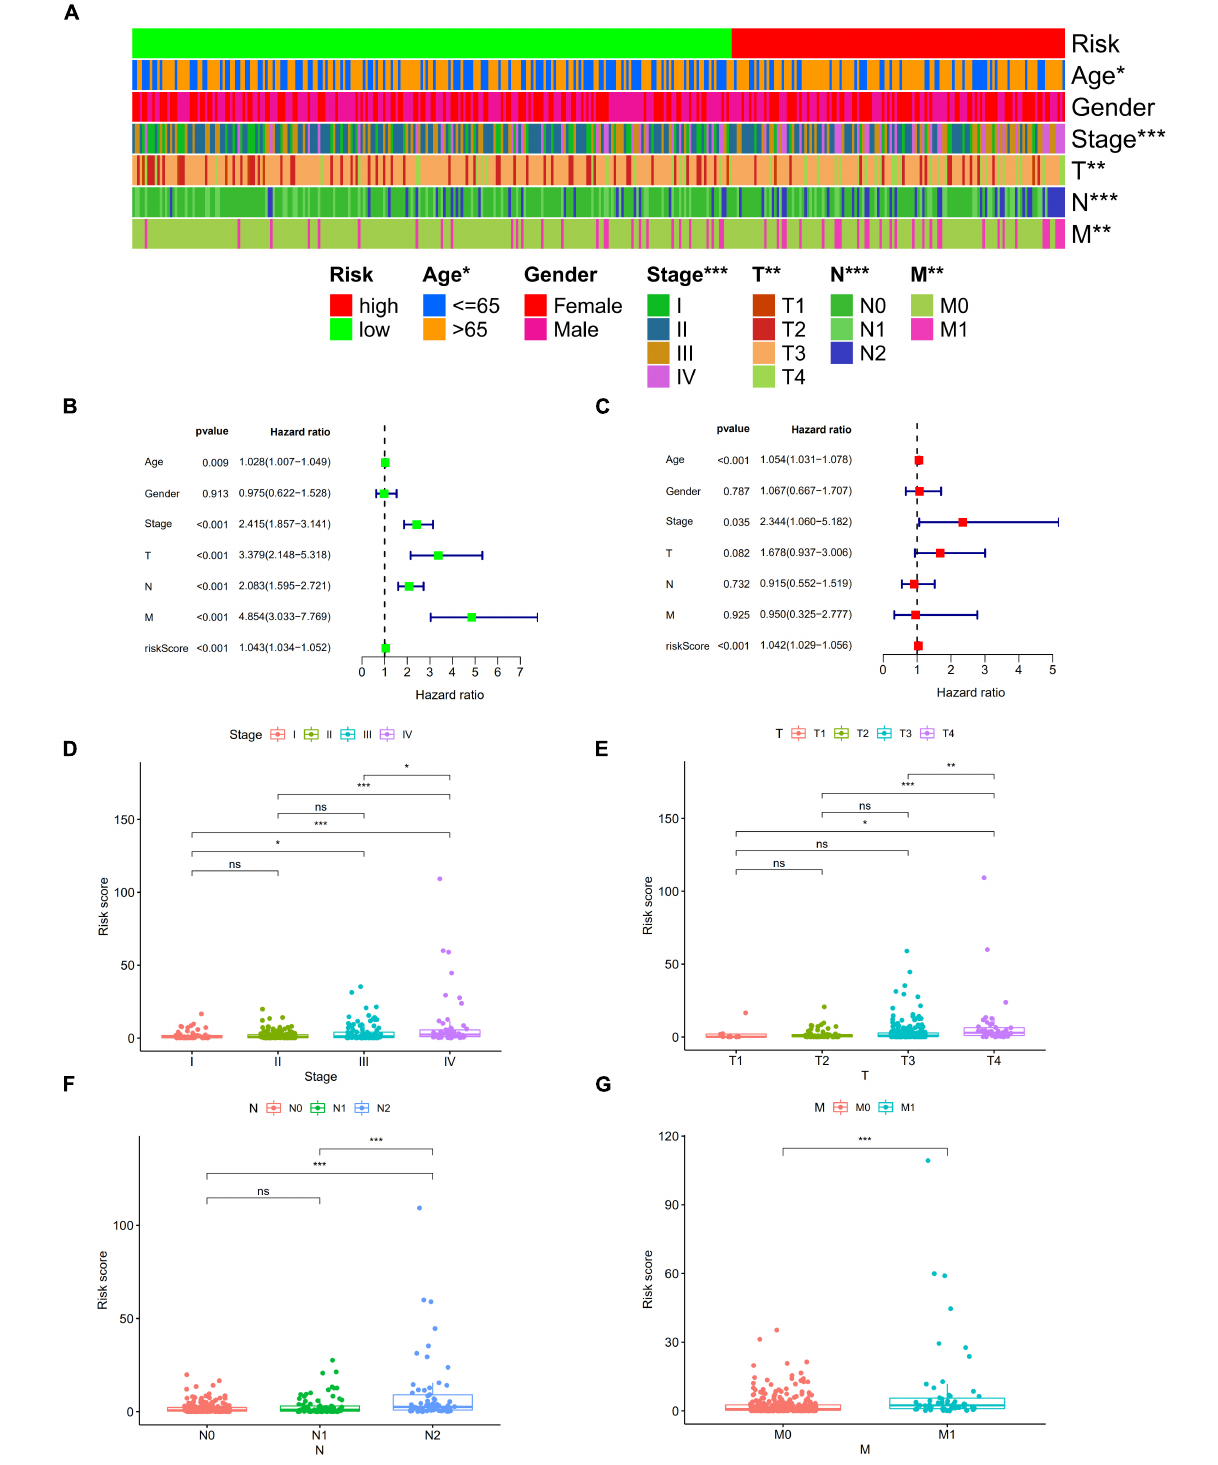
Frontiers in Cell and Developmental Biology |